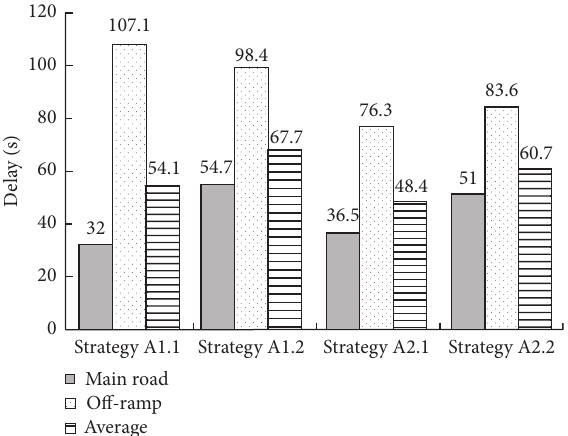
Figure 11: Vehicle delay comparison with main road flow 1600veh/h/lane and off-ramp rate